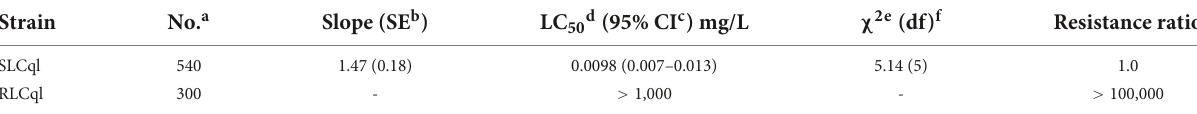
TABLE 1 Toxicity of Lysinibacillus sphaericus C 3 -41 ( Ls C 3 -41) to susceptible (SLCql) and resistant (RLCql) Culex quinquefasciatus .